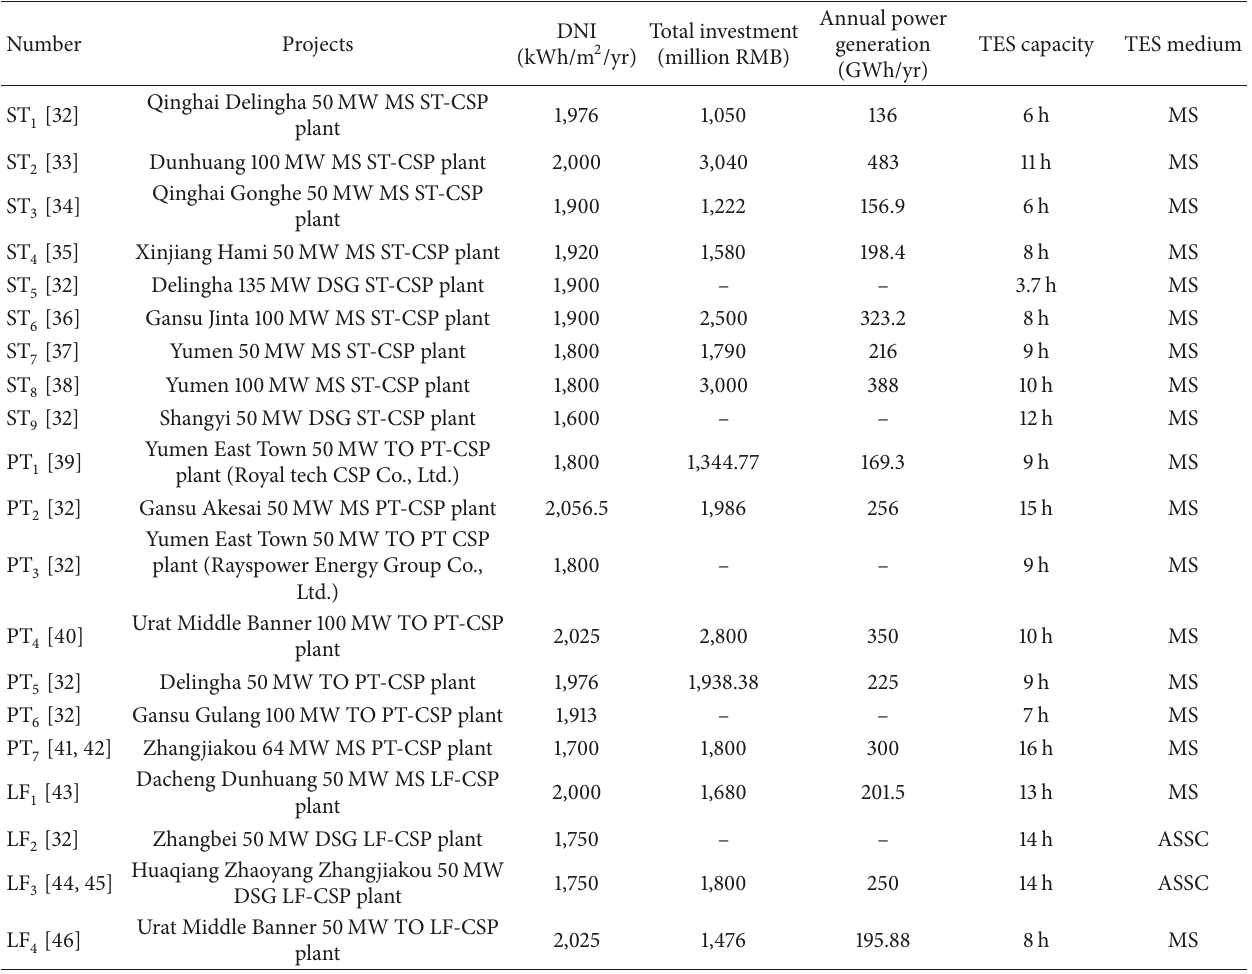
Table 1: Design parameters of CSP demonstration